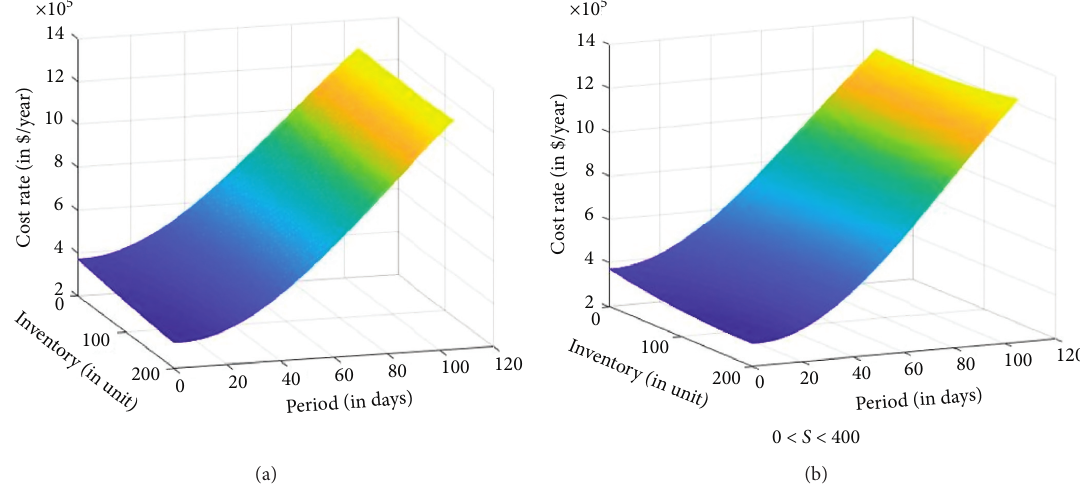
with T (in days) and S (in units). 1